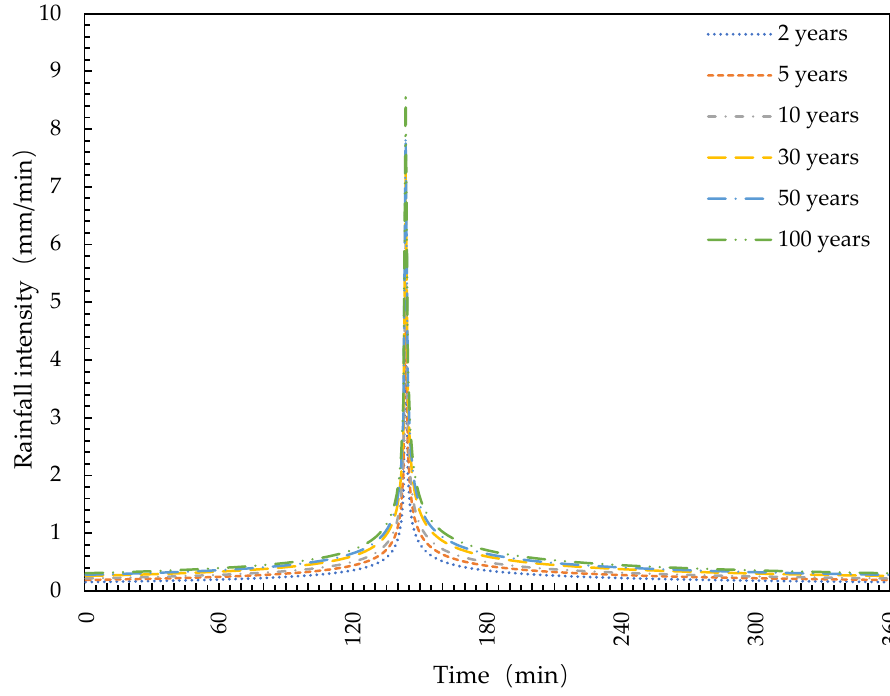
Figure 3. Design rainfall under different return periods of rainfall events in Qinhuangdao City.